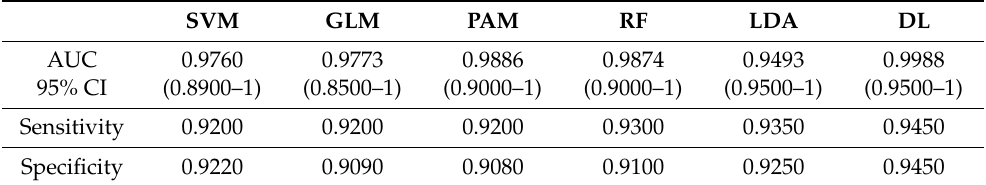
Figure 3. Visualization of gene network: Top 5 significant gene clusters are depicted- Calcium signaling pathway (q = 9.7 × 10 − 5 ), Glutamatergic synapse (q = 9.7 × 10 − 5 ), Hedgehog signaling pathway (q = 3.2 × 10 − 4 ), Axon guidance (q = 3.2 × 10 − 4 ) and Olfactory transduction (q = 4.4 × 10 − 4 ). Table 1. Artificial Intelligence and circulating cfDNA prediction for the Alzheimer’s disease intragenic CpGs (20 Variables Bootstrapping–Independent Test group).